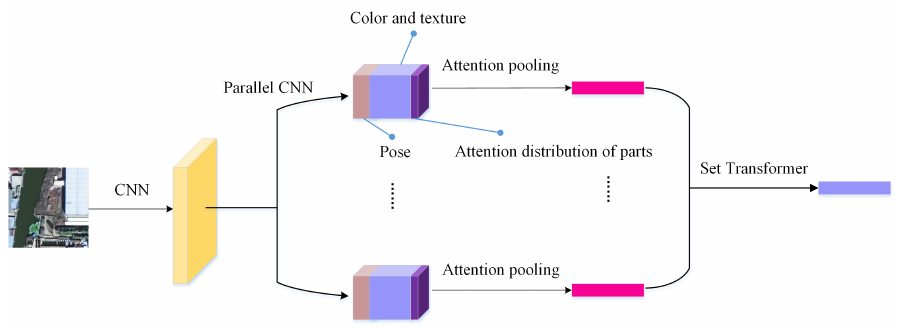
Figure 2. The architecture of our